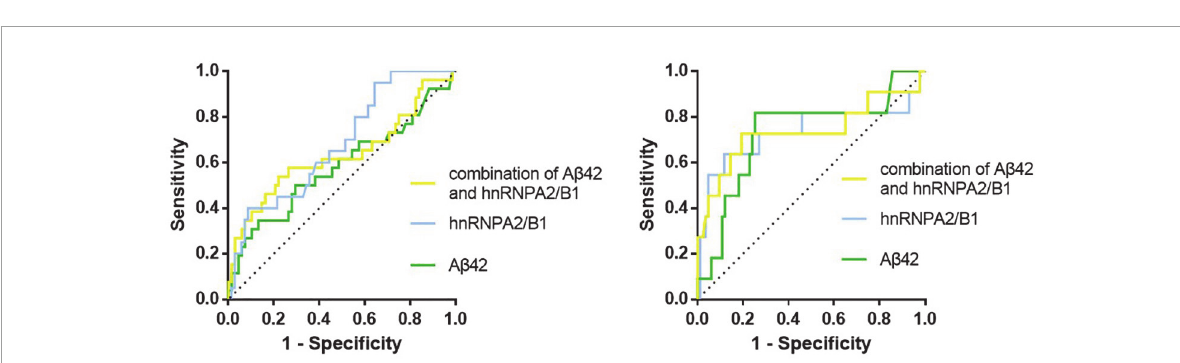
of conversion from neurodegeneration to dementia in the elderly (Lu et al., 2020; Rossi et al., 2020). Consistently, we found that the elderly with PND usually had a higher preoperative hnRNPA2/B1 level and this biomarker